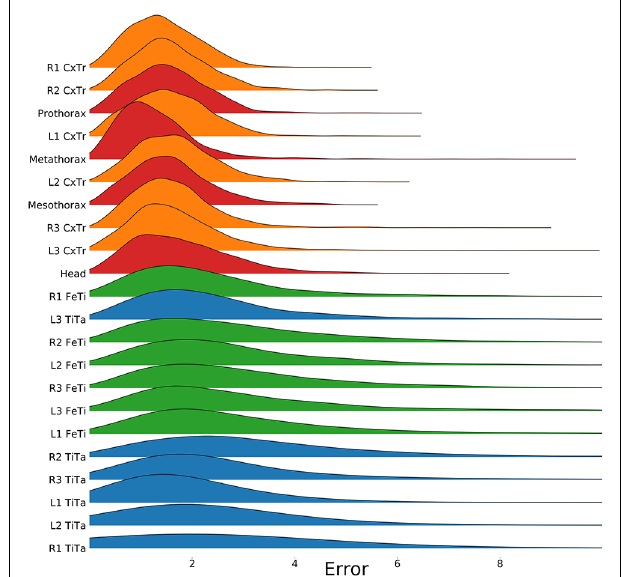
FIGURE 4 | Proximal body parts have lower errors than distal ones. Distributions show the pixel errors for 22 individual body features ( n = 1,600 per distribution). The error is the Euclidean distance between the ground truth and the network prediction. This particular model has been trained on a video which included random rotations and scaling (RS). Distributions were sorted from top to bottom by increasing standard deviation. The color code groups body parts according to a proximal-to-distal gradient (red: thorax and head; orange: coxae; green: tibiae; blue: tarsi). The scale factor converting pixels to mm was in the range of 0.18–0.55 mm/pixel, depending on the scaling factor of the random transformation.